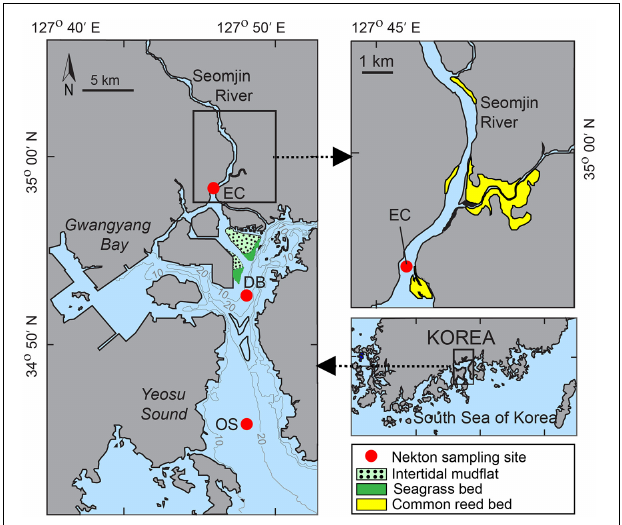
FIGURE 1 | Study area and locations of the sampling sites at the estuarine channel (EC), deep bay (DB), and offshore (OS) areas of Gwangyang Bay. Gray lines represent water depth. Red dots represent nekton, plankton, sediment, and water collection sites. Microphytobenthos (MPB), Phragmites australis , and Zostera marina samples were collected from intertidal mudflat, common reed bed and seagrass bed, respectively.